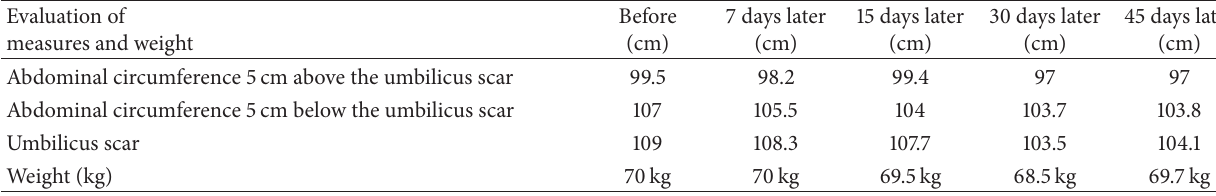
Table 1: Anthropometric data of the patient.